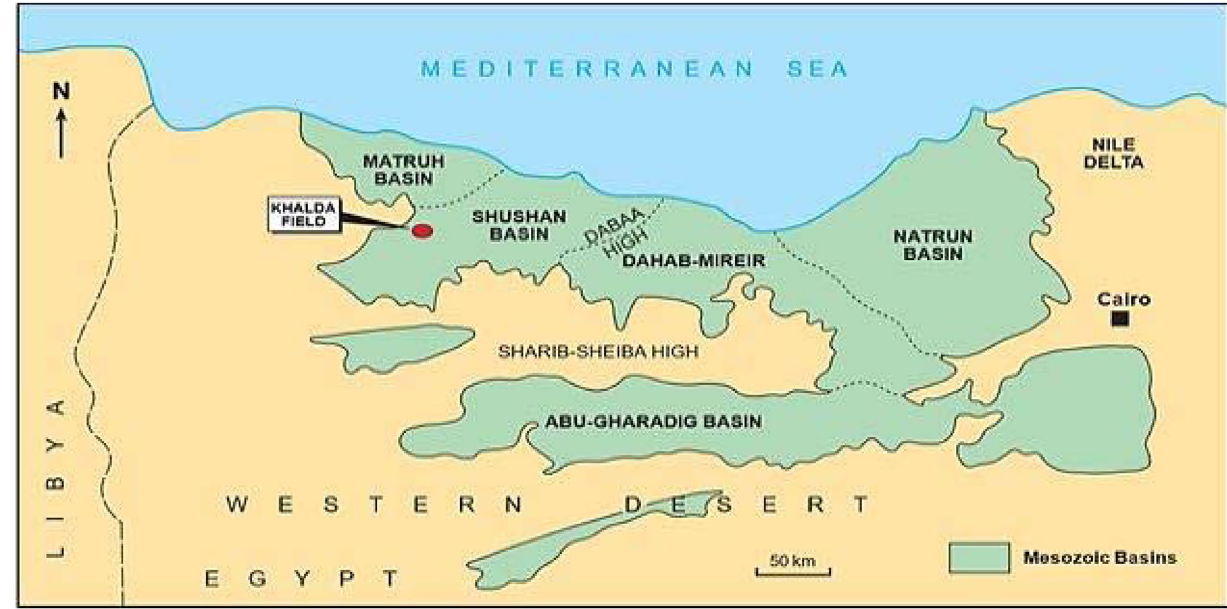
Fig. 1 Location map of the Khalda Oil Field and the Coastal Basins in north Western Desert, Egypt (Rossi et al.